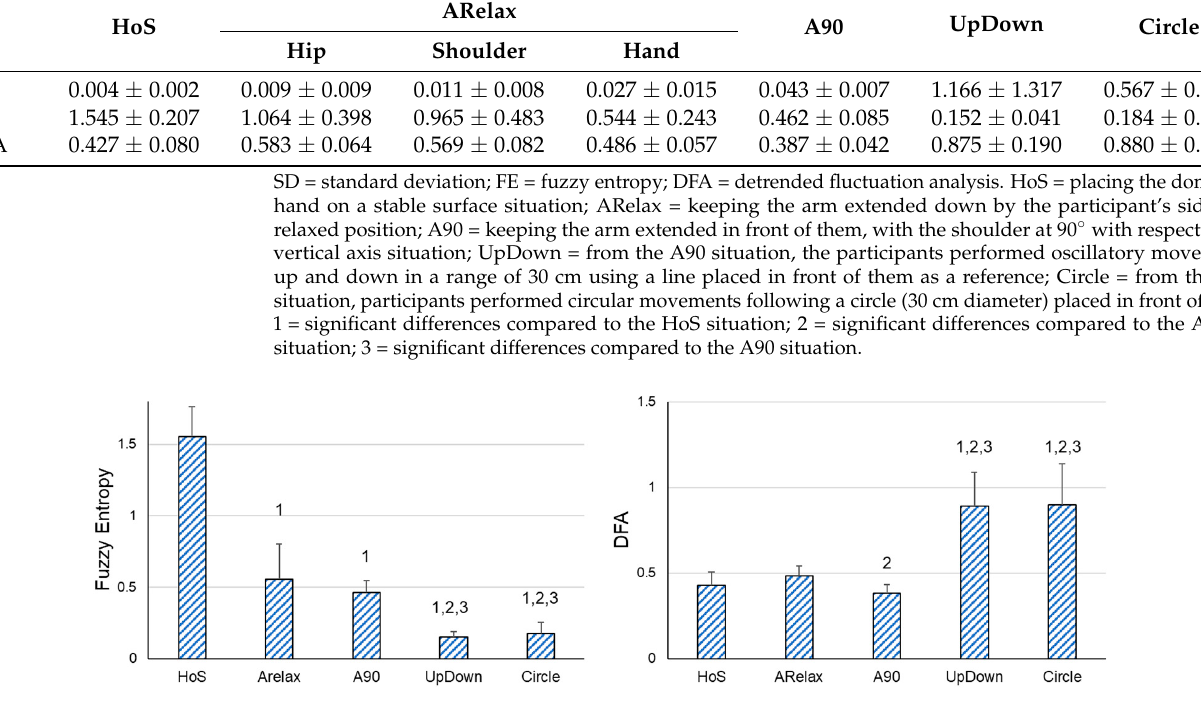
Table 1. Mean ± SD values of the amount (standard deviation) and structure (fuzzy entropy and